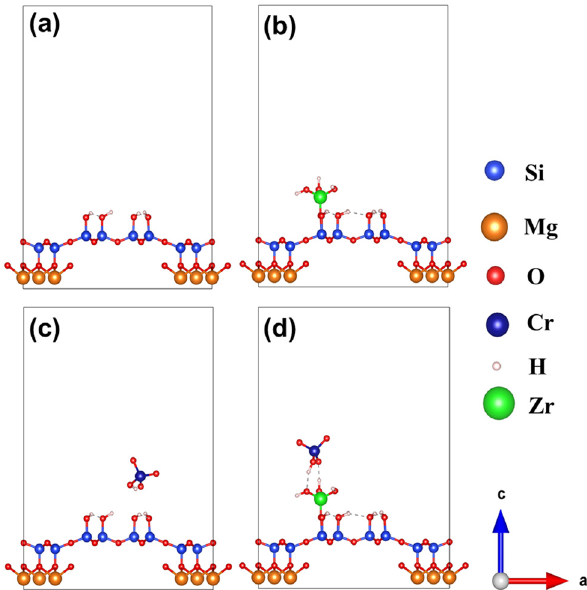
Figure 8: The optimized structures of ( a ) ATP, ( b ) Zr@ATP, ( c ) ATP after adsorbing HCrO 4− , and ( d ) Zr@ATP after adsorbing HCrO 4−